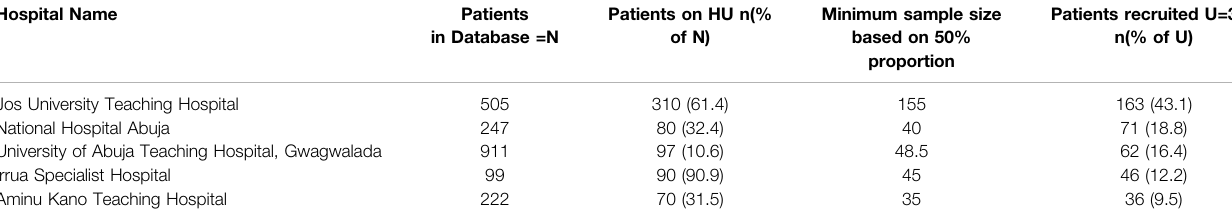
TABLE 1 | Patient distribution across participating centres